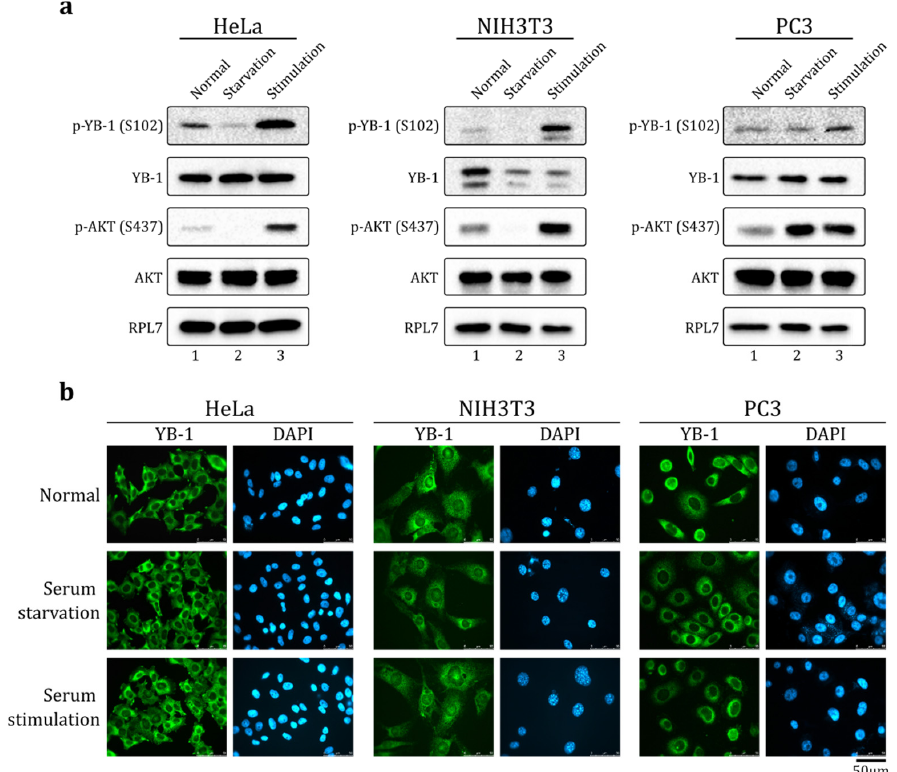
Figure 1. YB-1 is phosphorylated at S102 but is not translocated to the nucleus upon serum stimula- tion. HeLa (left panel), NIH3T3 (middle panel), and PC3 (right panel) cultivated in normal, serum starvation (24 h w/o FBS, fetal bovine serum), or serum stimulation (24 h without FBS + 2 h 20% FBS) conditions. The cells were ( a ) lysed and analyzed by Western blot using indicated antibodies, or ( b ) analyzed by immunofluorescence (IF) microscopy using antibodies against YB-1. Nuclei were visualized by DAPI